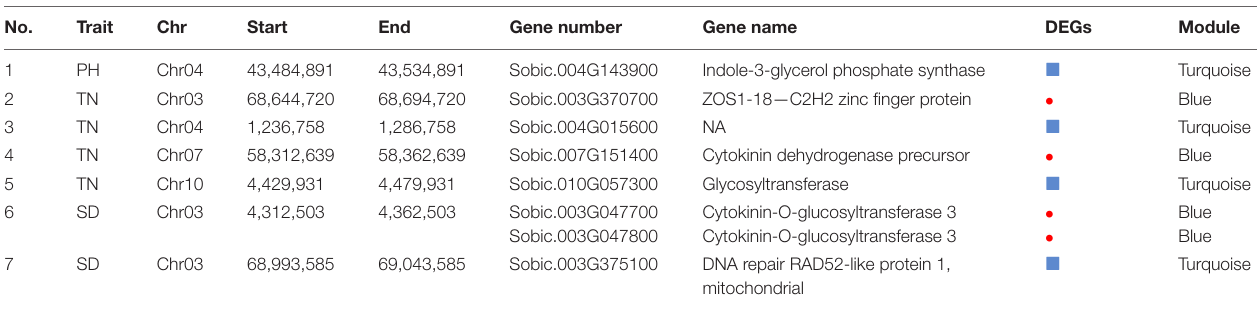
FIGURE 5 | Module-trait relationship from weighted gene correlation network analysis. (A) Module-trait map. (B) Significant correlation map between traits and modules. rd-represents direction of correlation; rv-represents size of r -value. TABLE 4 | Candidate yield-related genes in forage